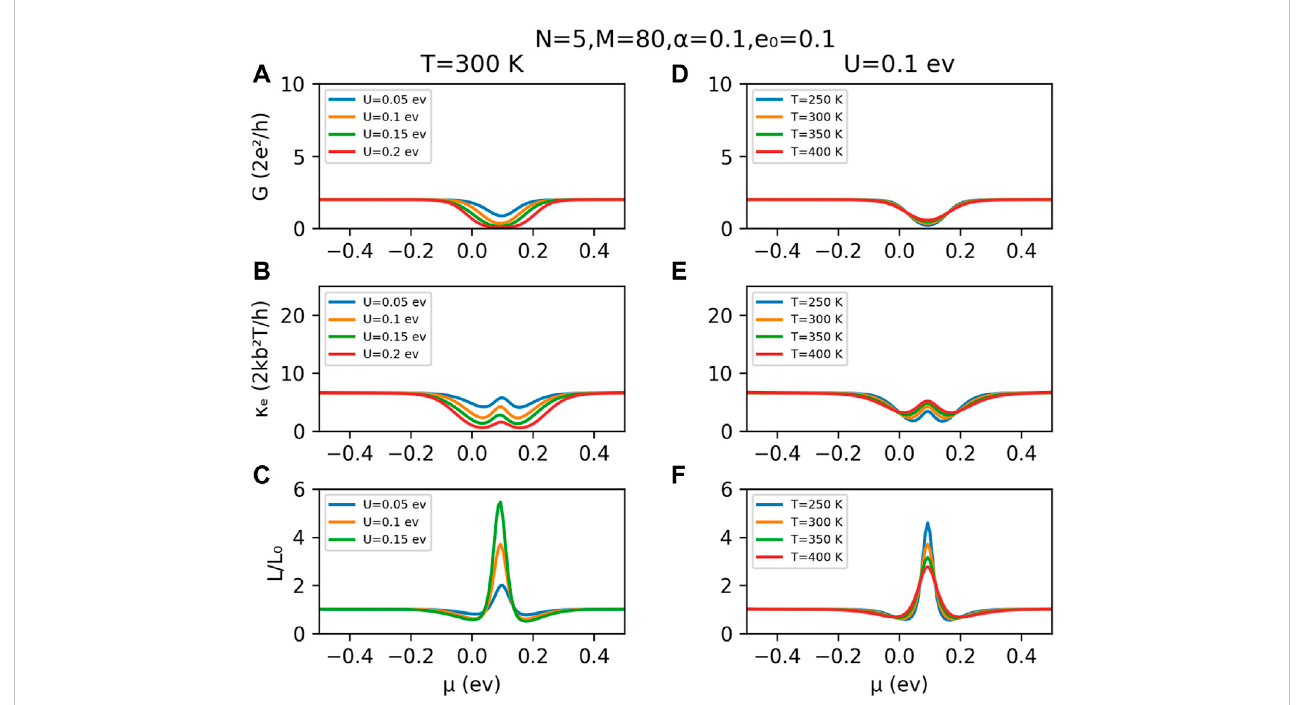
FIGURE 5 Electronicconductance,electronicthermalconductance,andLorenznumberforanA-SNRofwidth N =5andlength L =80.Wehaveplottedpanels (A) , (B), and (C) forroomtemperature,increasingtheexternalpotentialintensity.Inpanels (D) , (E), and (F), wehaveconsideredvariationsofthetemperatureofthe